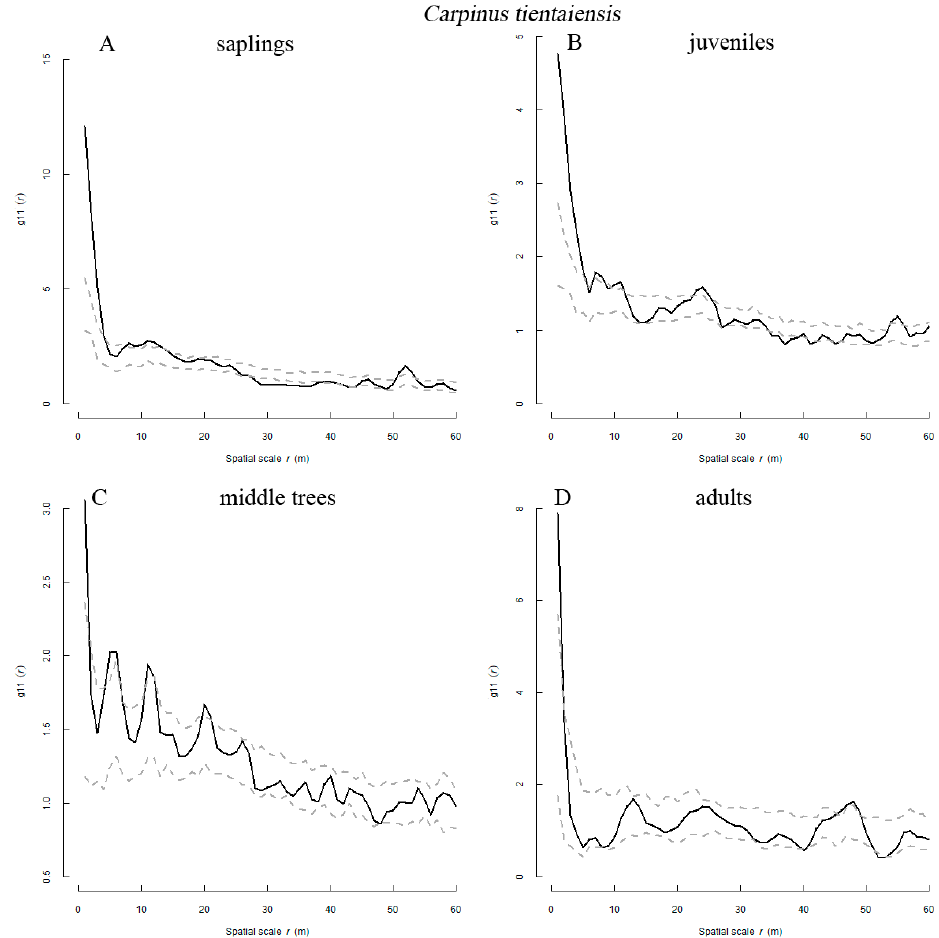
Figure 3. Spatial patterns of Carpinus tientaiensis among different DBH classes in the Carpinus tientaiensis sampling plot. Note: The insertions at figure a indicate the point patterns analysis of three size classes (saplings as 1 cm ≤ DBH < 5 cm, juveniles as 5 cm ≤ DBH < 10 cm, middle trees as 10cm ≤ DHB < 20 cm and adults as DBH ≥ 15